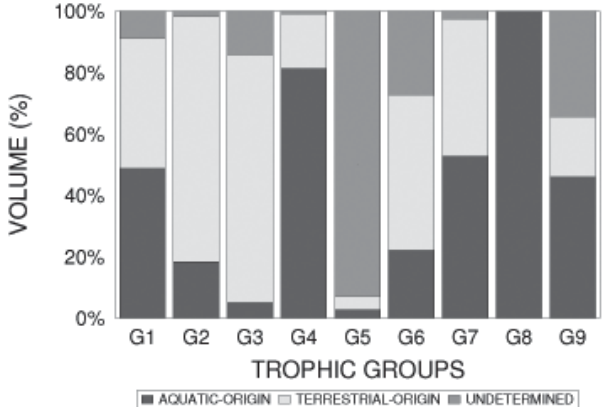
Fig. 2 . Proportions of terrestrial, aquatic, and undetermined resources used by the fish trophic